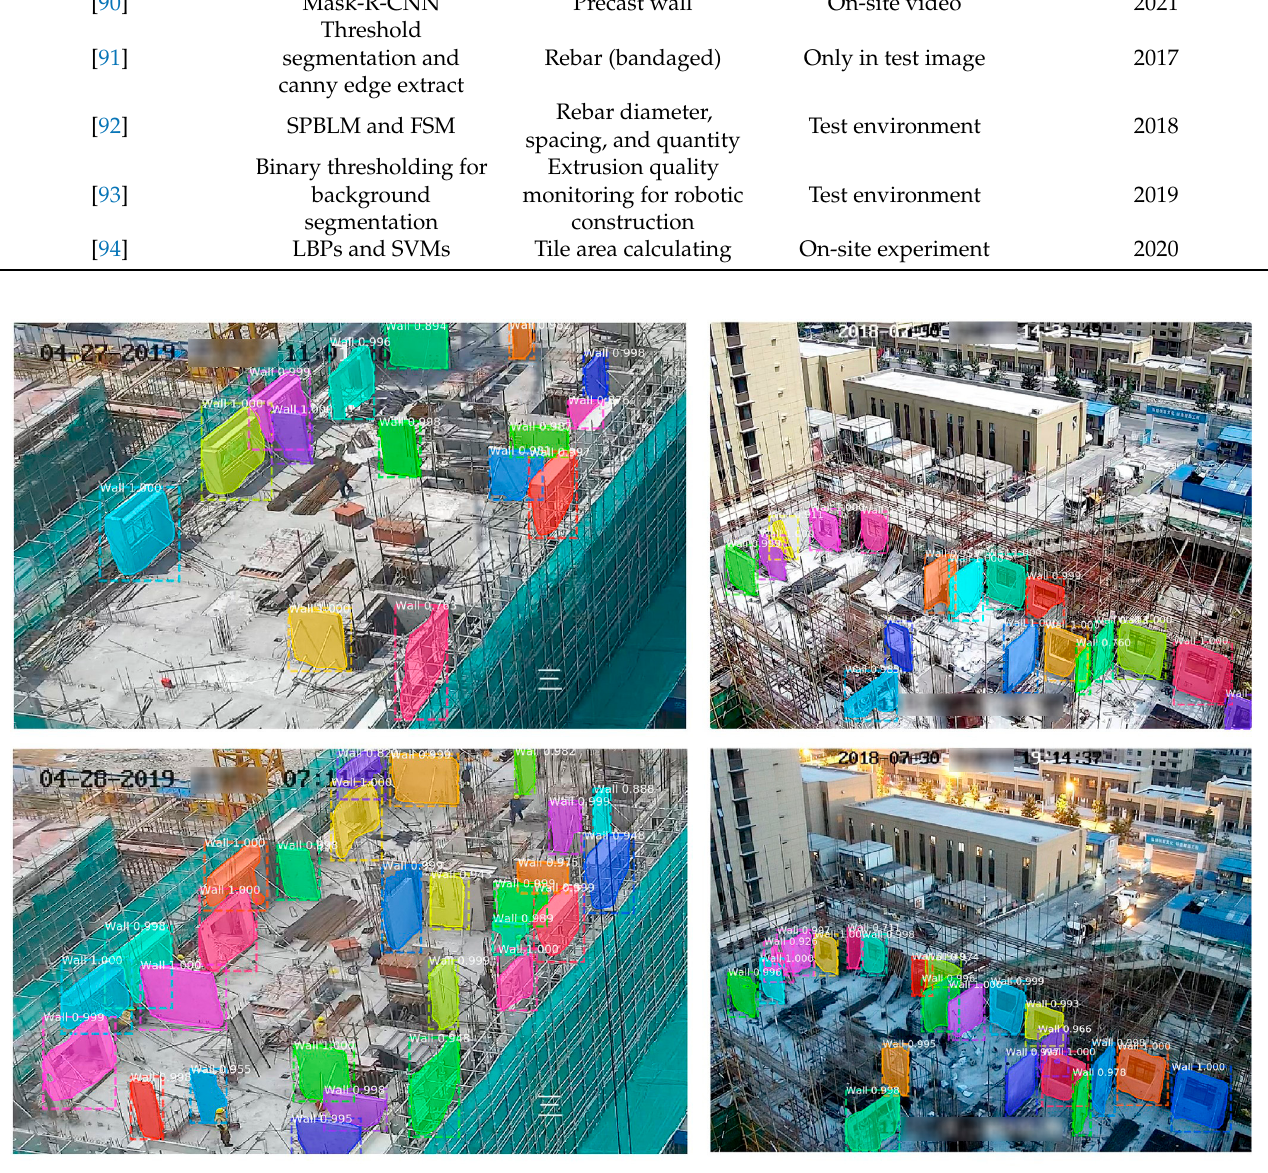
Figure 8. Detection and tracking of pre -cast components [90].